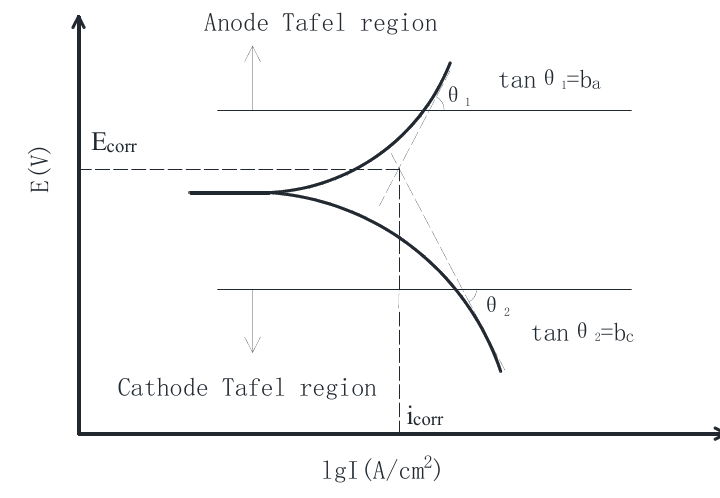
Figure 1. Tafel potentiodynamic polarization (TPP) curve fitting.